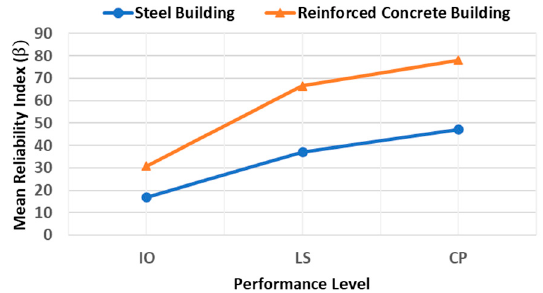
Figure 15. Mean reliability index for steel and reinforced concrete buildings located at Chilpancingo, Guerrero (seismic zone D).